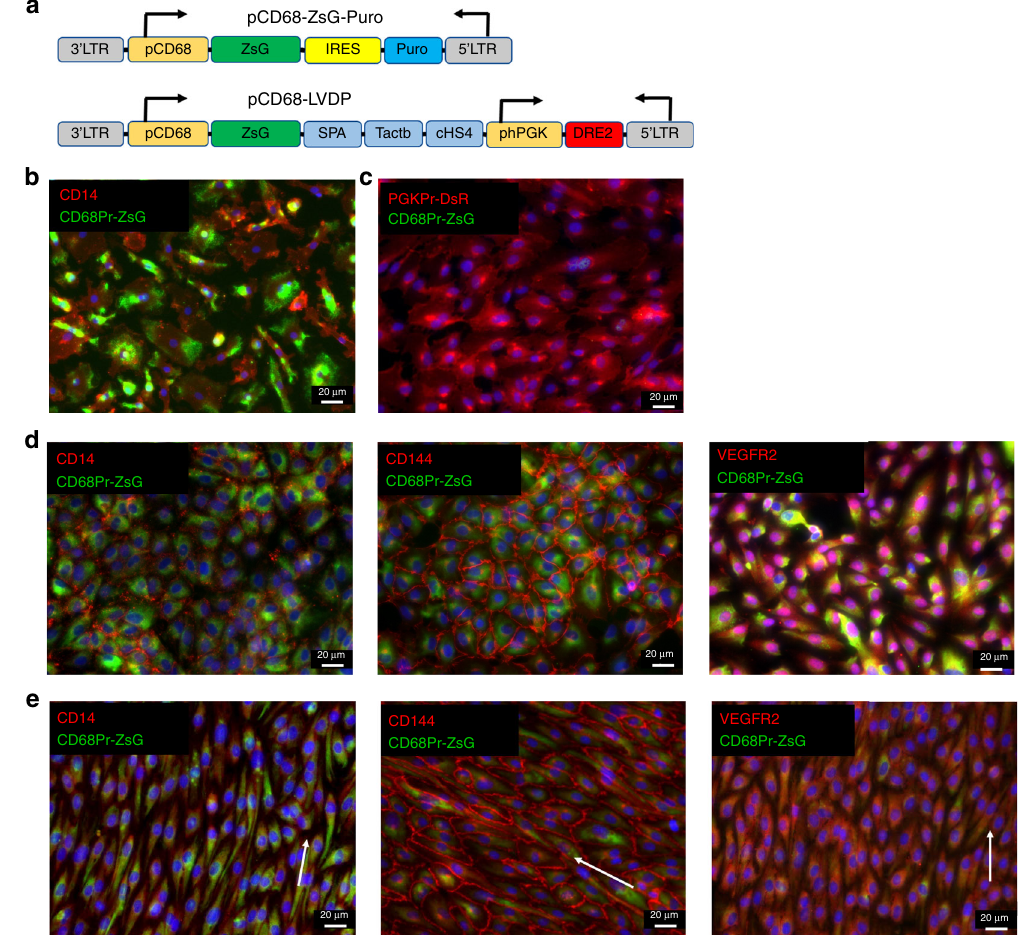
Fig. 10 CD68 promoter driven selection of MC for differentiation. a Schematic of lentiviral vectors encoding for ZsGreen and puromycin phosphotransferase under the CD68 promoter (CD68-Pr; pCD68-ZsG-Puro) and Schematic of lentiviral dual promoter (LVDP) encoding for ZsGreen under the CD68-Pr and DsRed under the human (h)PGK promoter (pCD68-LVDP). The two transcriptional units are separated by polyadenylation (SPA, synthetic polyA), terminator (Tactb), and insulator (cHS4) sequences that diminish promoter interference 36,37 . b Immunostaining of MC transduced with lentiviral vector shown in ( a ) and selected with puromycin (ZsGreen + ) for the MC marker CD14 (red) prior to differentiation. c HCAEC cells were transduced with the lentiviral dual promoter vector shown in b . They express DsRed but not ZsGreen indicating that CD68 is inactive in HCAEC. d , e Immunostaining for MC marker CD14 and EC markers CD144 and VEGFR2 (red) of puromycin selected MC (ZsGreen + ) that were coaxed to differentiate towards EC under ( d ) static or ( e ) shear stress conditions. Scale Bar: 20 µ